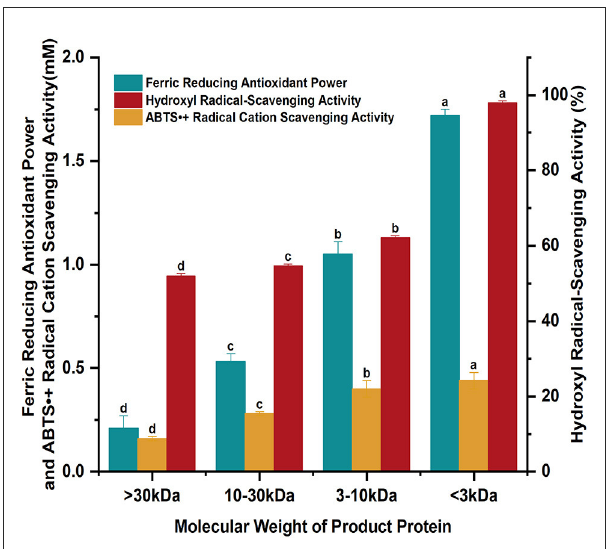
FIGURE4 The antioxidant properties of the enzymatically digested proteins from soybean meal.